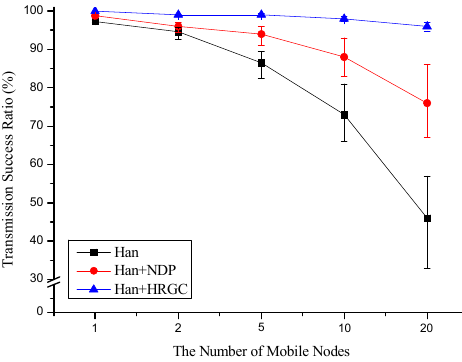
Figure 7. Transmission success ratio vs. the number of mobile